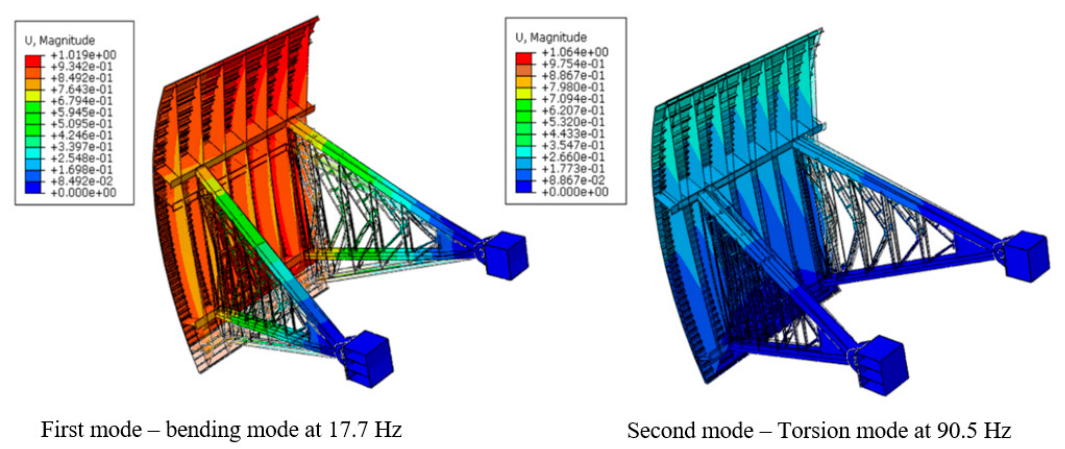
Figure 7. First and second mode shapes of modal analysis.